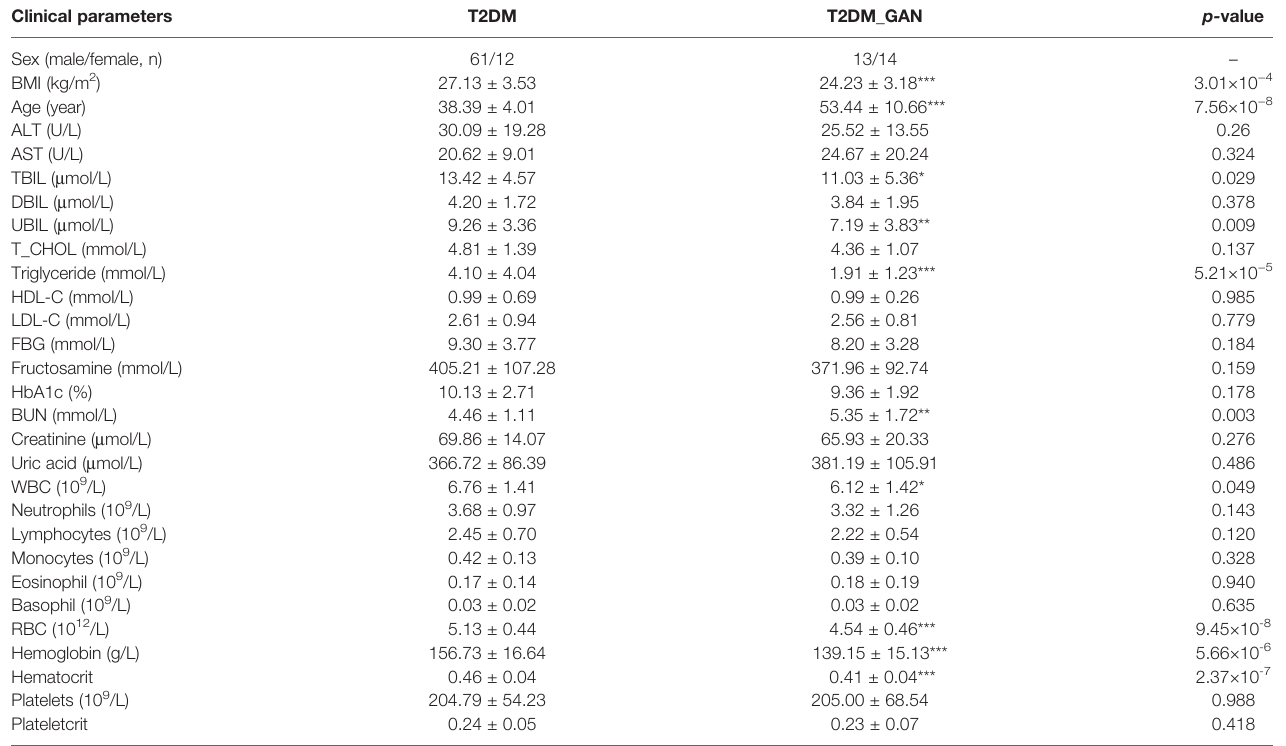
TABLE 1 | Characteristic of the patients with T2DM and T2DM-GAN in the study. Clinical